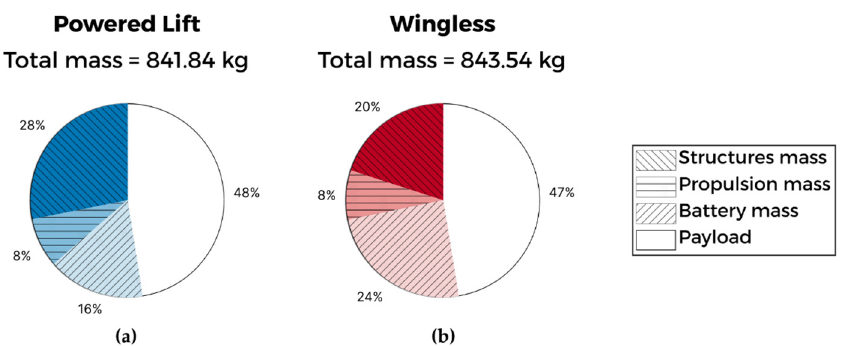
Figure 13. Aircraft mass breakdown for ( a ) powered lift and ( b ) wingless eVTOL aircraft types.